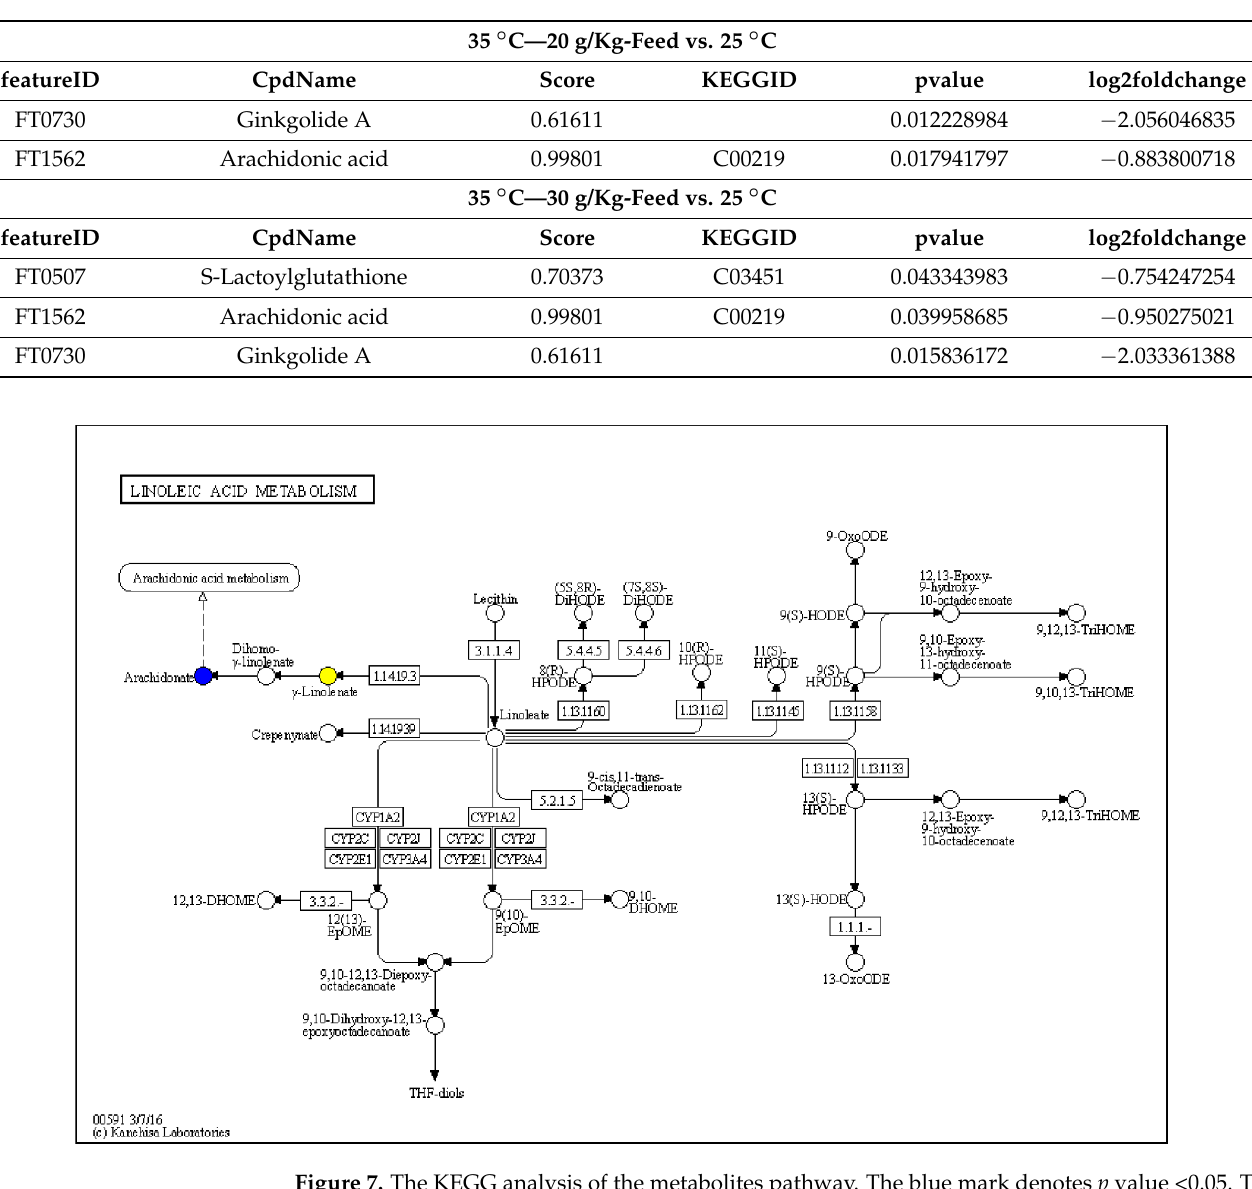
Figure 7. The KEGG analysis of the metabolites pathway. The blue mark denotes p value <0.05. The yellow mark denotes p value > 0.1.